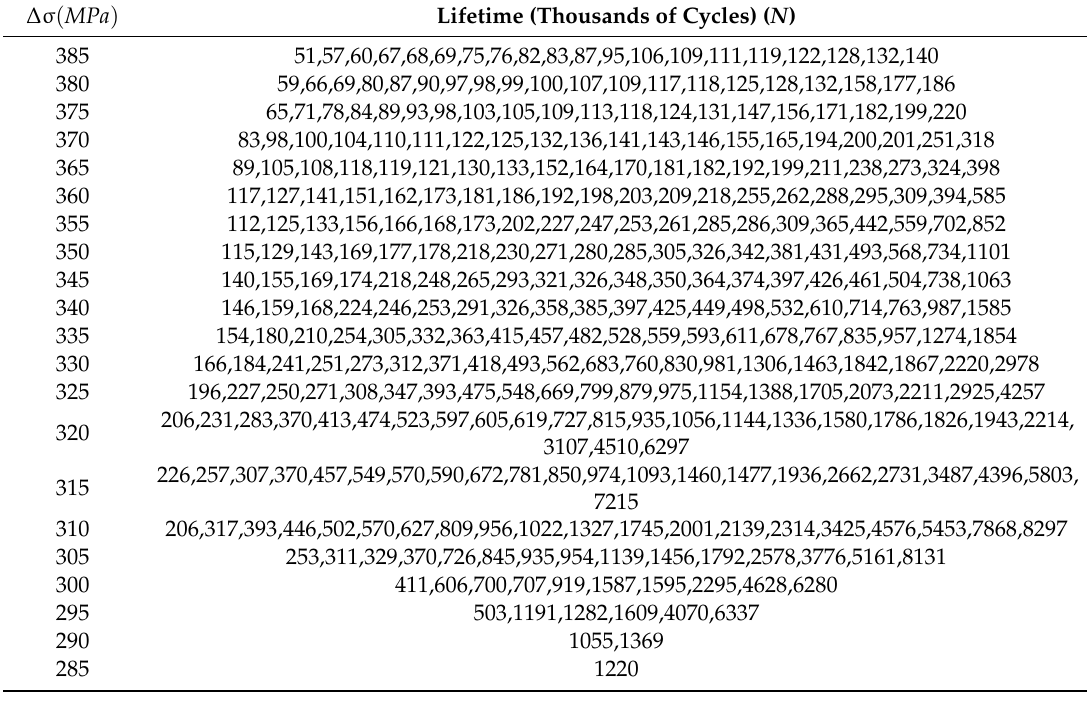
Table 1. Maennig fatigue